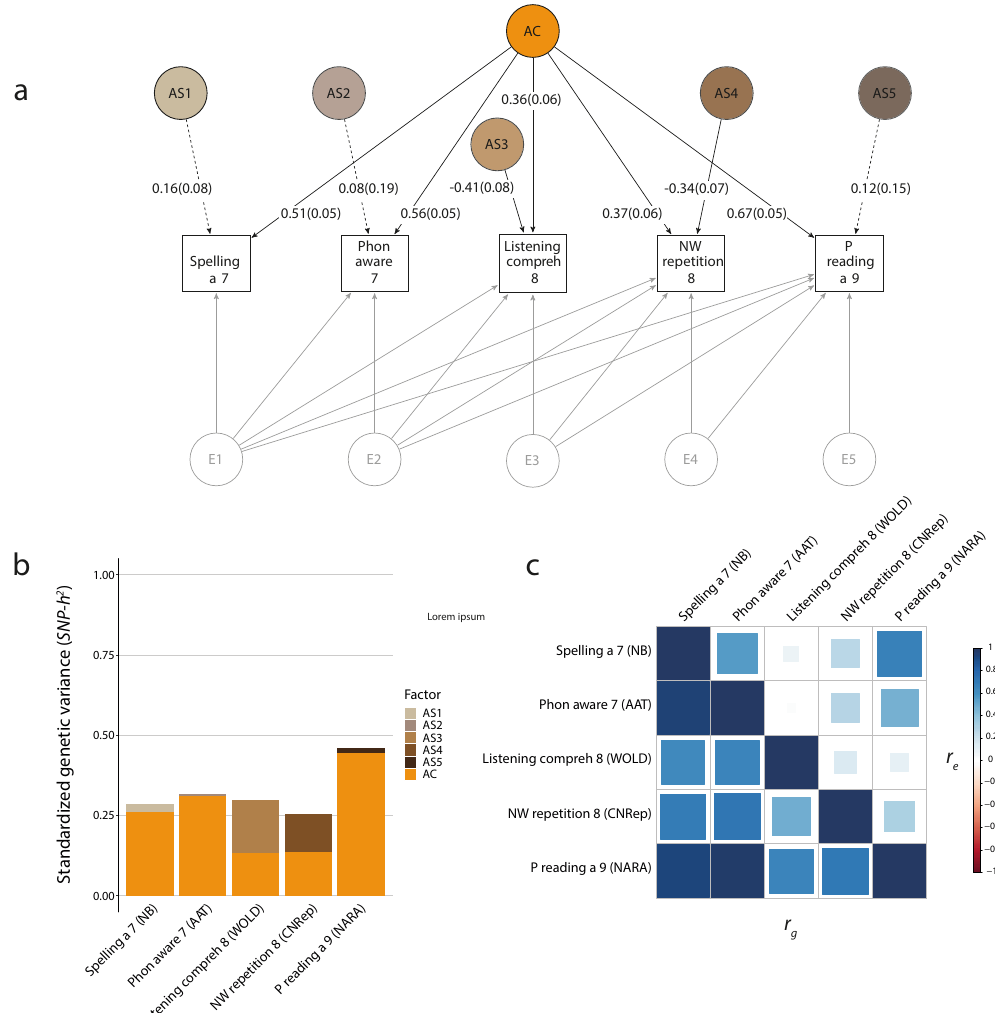
Fig. 2 Multi-domain structural model (Passage reading subset). Genetic-relationship matrix structural equation modeling (GSEM) of literacy, phonological awareness, language and PWM abilities ( N = 6453). The path diagram ( a ) depicts the genetic factors of the best- fi tting model (IPC model) describing variation in spelling accuracy at age 7 (Spelling a 7, NB), phonemic awareness at age 7 (Phon aware 7, AAT), listening comprehension at age 8 (Listening compreh 8, WOLD), non-word repetition at age 8 (NW repetition 8, CNRep), and passage reading accuracy at age 9 (P reading a 9, NARA). The phenotypic variance was dissected into common (AC) and speci fi c (AS1-AS5) genetic factors, according to an Independent Pathway model, as well as residual factors (E1-E5), based on a Cholesky decomposition (Factor loadings are not shown, Supplementary Table 13, Supplementary Fig. 4). Observed measures are represented by squares and factors by circles. Single-headed arrows (paths) de fi ne relationships between variables. Dotted and solid paths represent factor loadings with p > 0.05 and p ≤ 0.05 respectively. The variance of latent variables is constrained to unit variance; this is omitted from the diagram to improve clarity. The variance plot ( b ) depicts the standardized genetic variance components for the model in a . The correlogram ( c ) shows genetic ( r g , lower triangle) and residual ( r e , upper triangle) correlations for the model in a . Point estimates and their SEs are reported in Supplementary Table 16. All measures were rank- transformed. IPC model – Combined Independent Pathway/Cholesky 44% (SE = 0.14), and 53% (SE = 0.14) of the genetic variance for factor across all the abilities studied (Fig. 2a and Supplementary each measure respectively (Supplementary Table 14). Thus, the Table 13), capturing between 13% (SE = 0.04) and 45% (SE = 0.07) majority of genetic variance across all traits (>90%) is captured by of the phenotypic variance of each trait and, thus, a large a shared genetic factor. Additional measurement-speci fi c genetic proportion of SNP-h 2 (Fig. 2b, factorial co-heritabilities >44%; in fl uences, re fl ecting here trait-speci fi c genetic variation, were Supplementary Table 14). This is re fl ected in moderate to strong estimated for listening comprehension and non-word repetition genetic correlations between traits ( r g = 0.49 – 0.97), even between (Fig. 2a). These factors explained 17% (SE = 0.06) and 12% (SE = passage reading accuracy and listening comprehension ( r g = 0.66 0.05) of the phenotypic variance respectively (Supplementary with SE = 0.11, Fig. 2c and Supplementary Table 15). The shared Table 13 and Fig. 2b), corresponding to 56% (SE = 0.14) and 47% genetic factor explained 27% (SE = 0.05) of the phenotypic (SE = 0.14) of the SNP-h 2 (Supplementary Table 14). variance for spelling accuracy, 31% (SE = 0.06) for phonemic awareness and 45% (SE = 0.07) for passage reading, but only 13% Identi fi ed multivariate model structures for the second dataset, (SE = 0.04) for listening comprehension and 14% (SE = 0.04) for including the reading fl uency proxy word reading speed (age 13) non-word repetition (Fig. 2b and Supplementary Table 13). This (Fig. 3), assessed ~4 years later than passage reading accuracy corresponds to 91% (SE = 0.08), 98% (SE = 0.1), 97% (SE = 0.08), (age 9), con fi rmed the fi ndings above. Model fi tting indices, again,